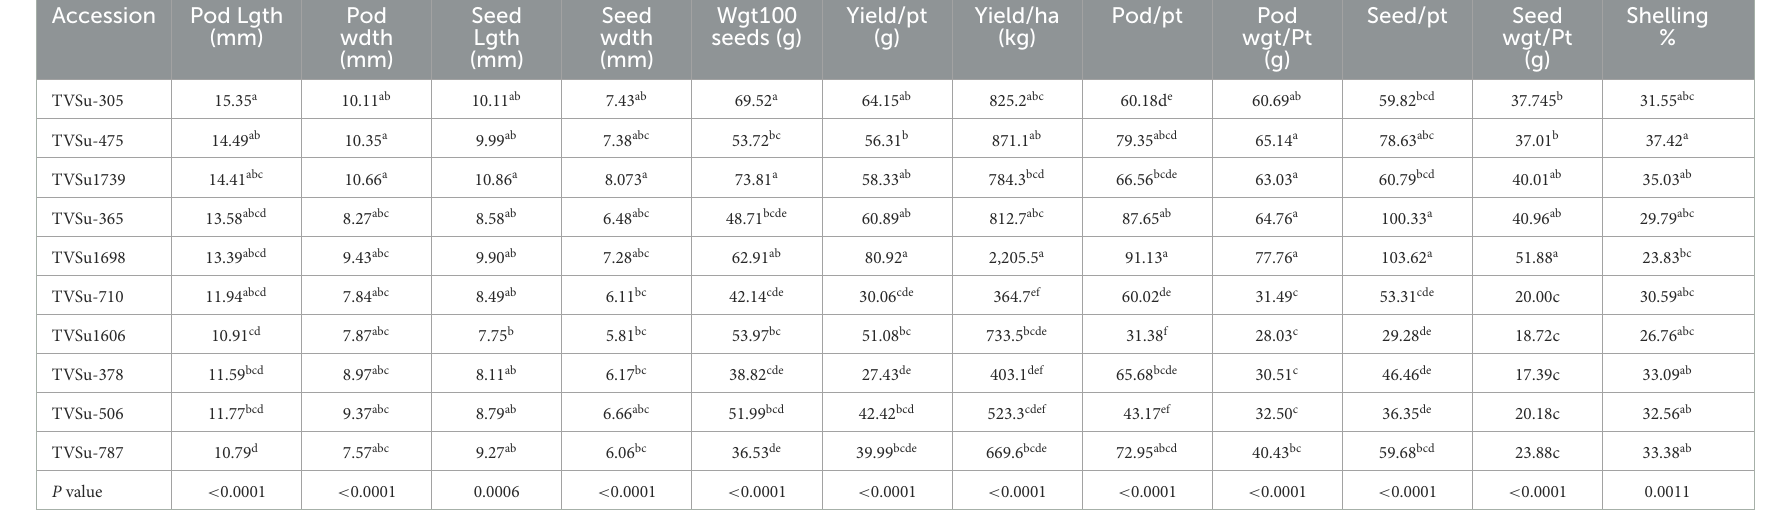
TABLE 7 Effect of treatments on BGN accessions in Ibadan and Ikenne in both cropping